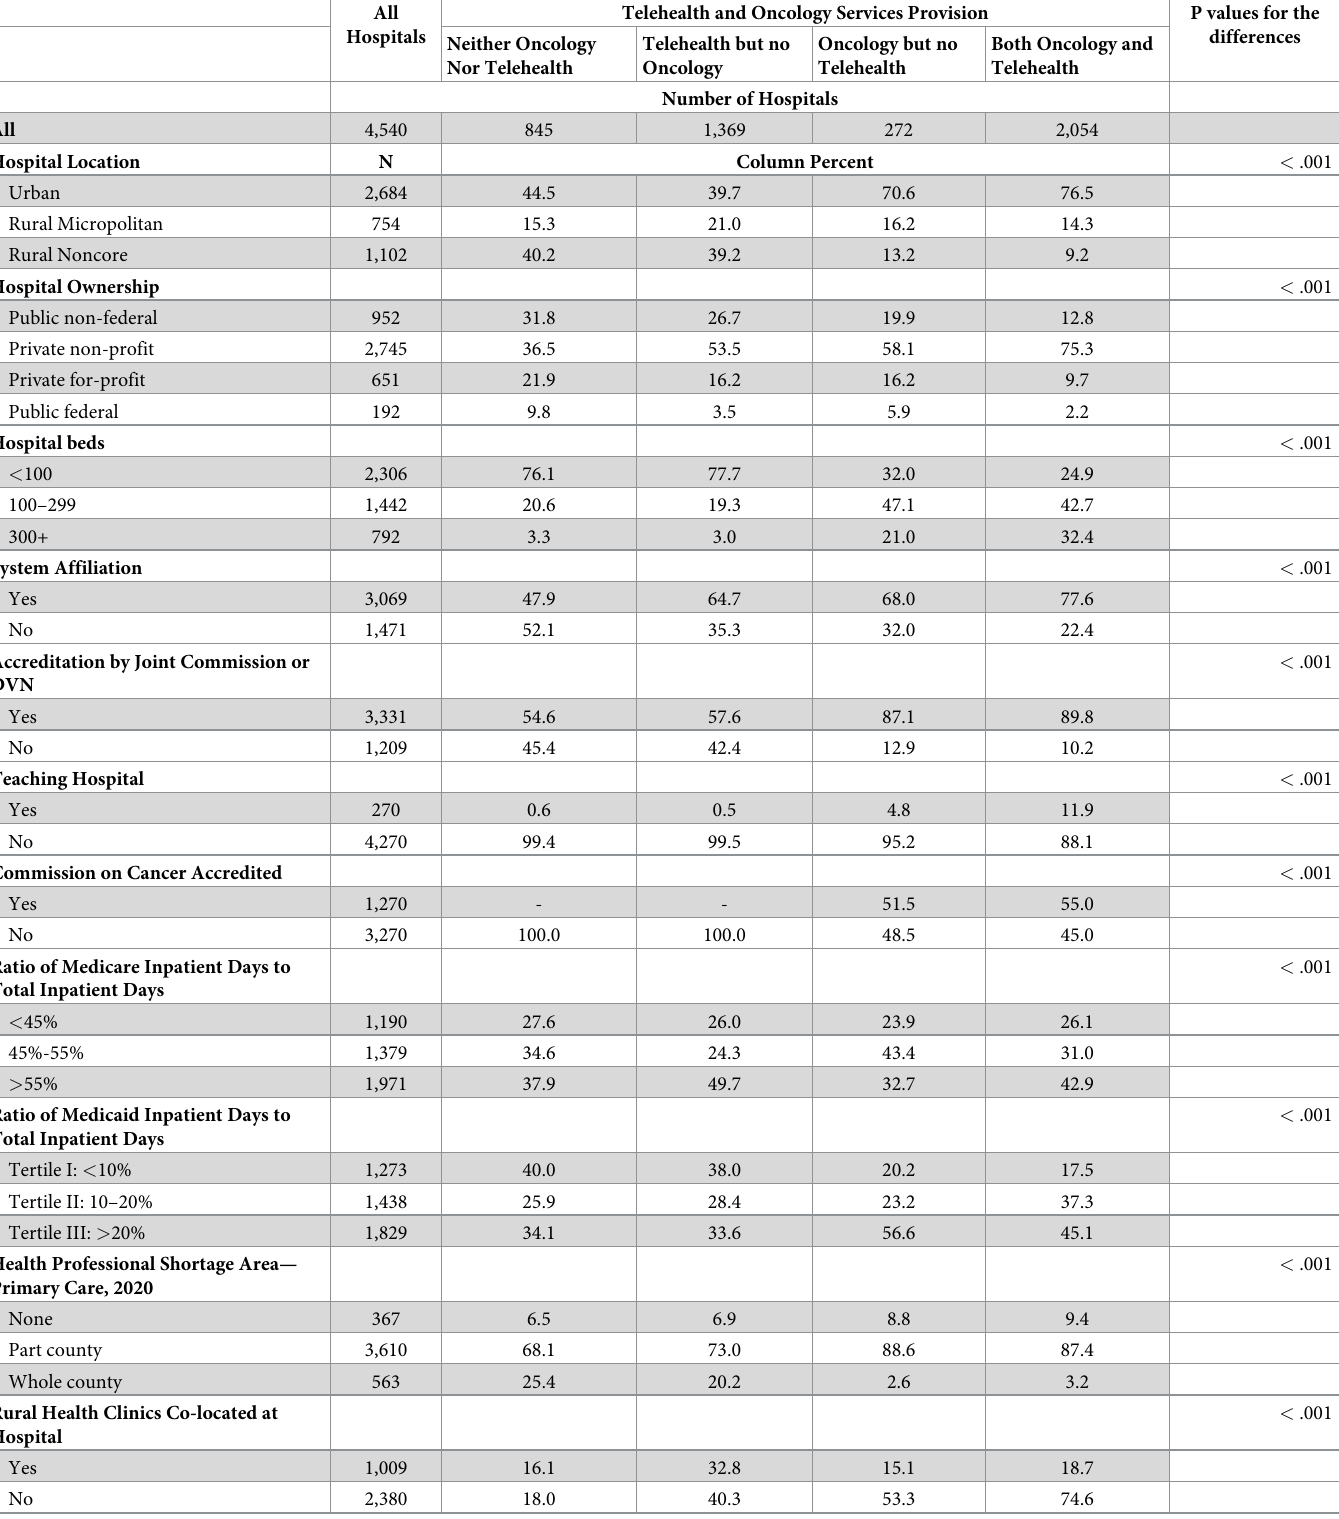
Table 1. Hospital characteristics by telehealth and oncology services provision status, 2019.